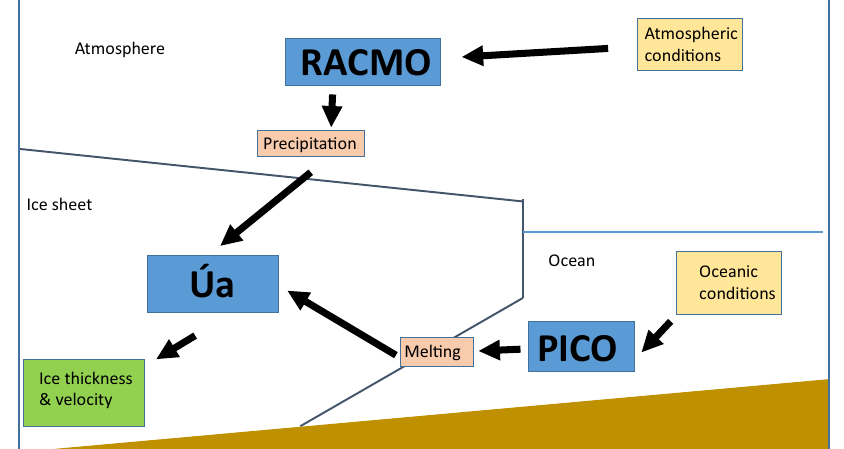
Fig. 6 | Schematic set up of model framework. The ice dynamics model Úa is forced with oceanic melt rates derived by the PICO (Potsdam Ice-shelf Cavity mOdel) box model and RACMO (Regional Atmospheric Climate Model) precipita- tion. PICO uses an ensemble of CMIP5 model mean ocean properties to derive its